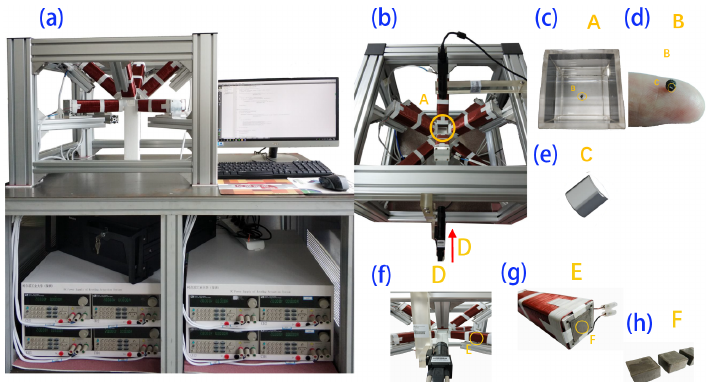
Figure 7. Rectangular electromagnetic coil set actuation platform. ( a ) System setup. The power